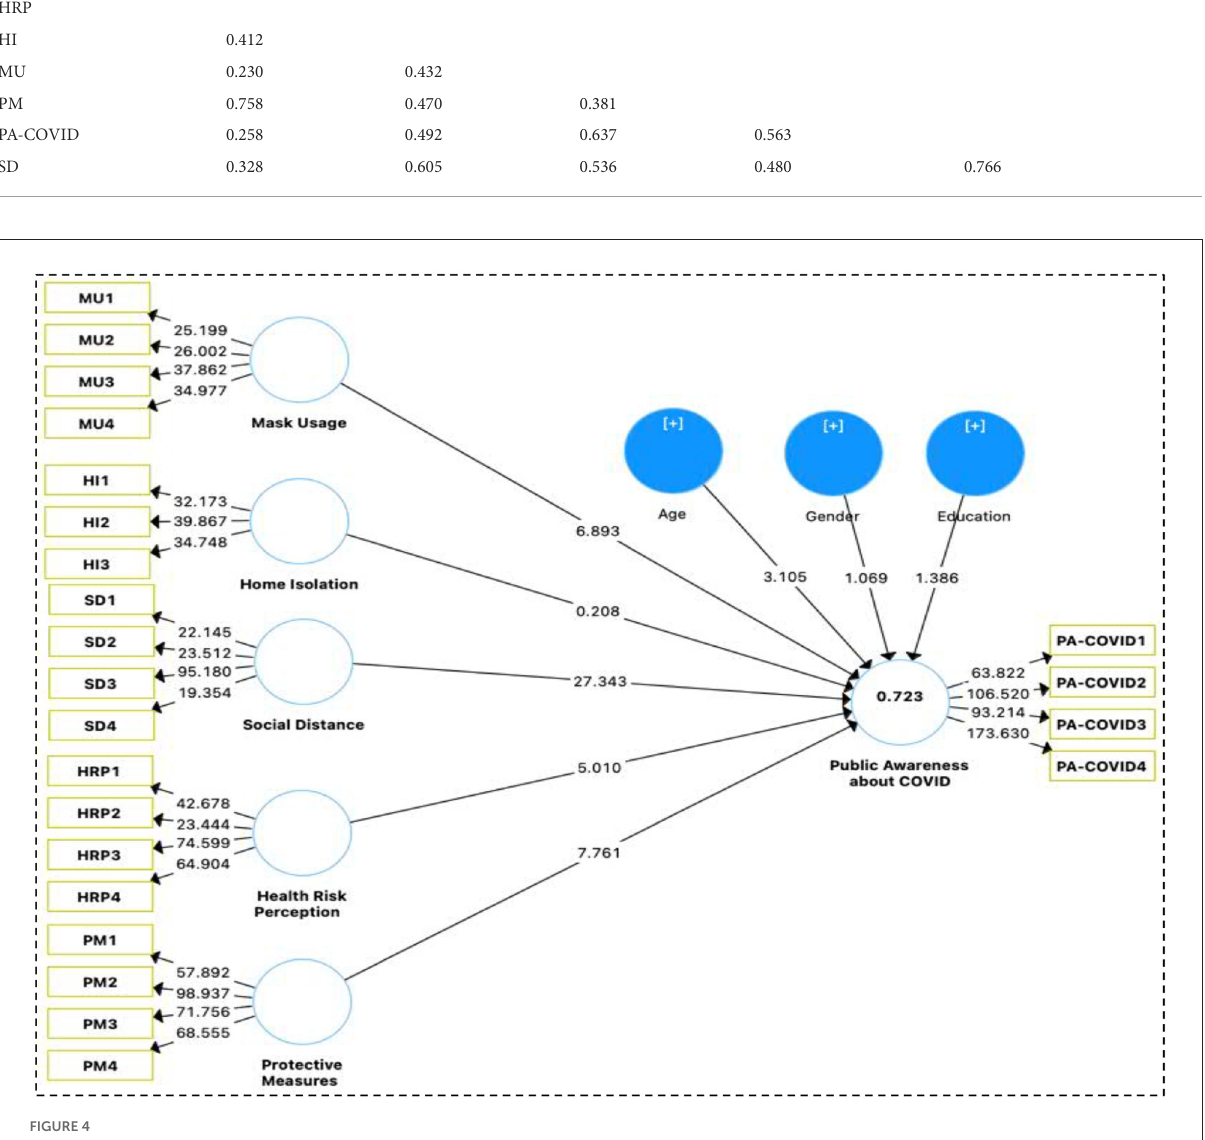
FIGURE4 PLS-SEM path